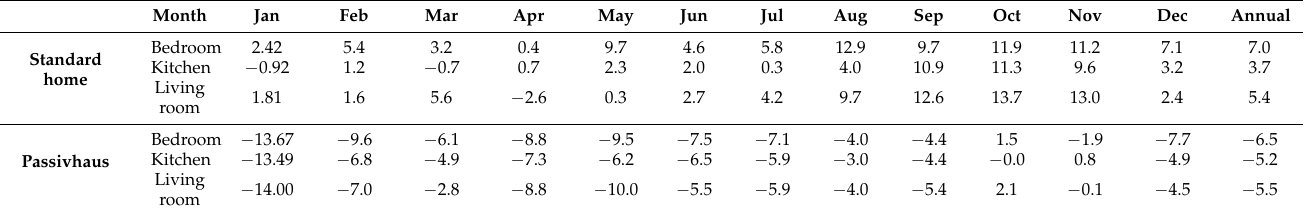
Table 4. Monthly indoor–outdoor differences of the PM 2.5 levels. Source: Authors.